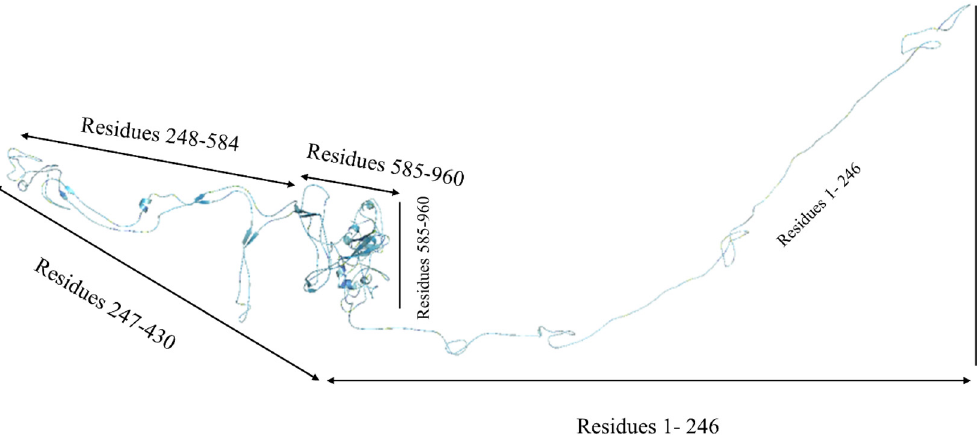
Figure 4: DNN-based predicted model of POTEE